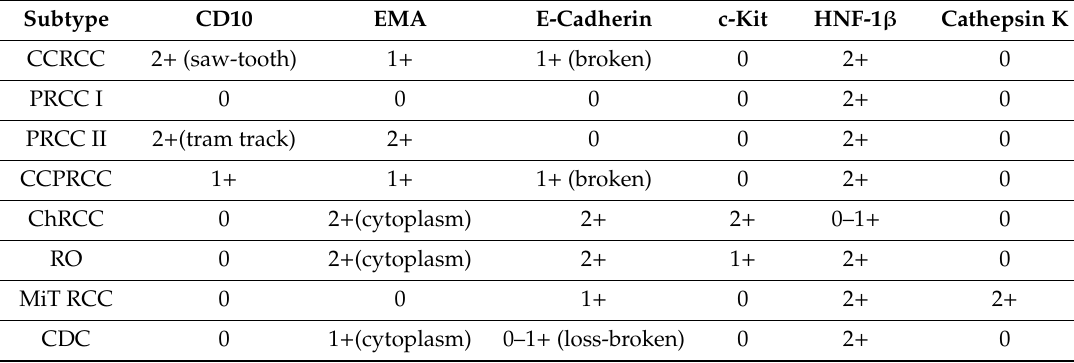
Table 3. Additional hexapanels for adjunctive renal cell carcinoma